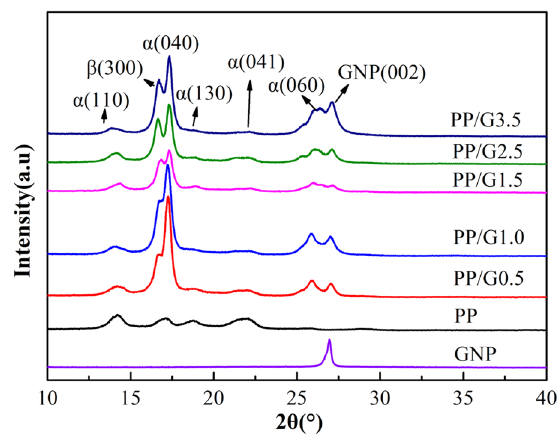
Figure 2: XRD patterns of neat PP and PP/GNP nanocomposites.